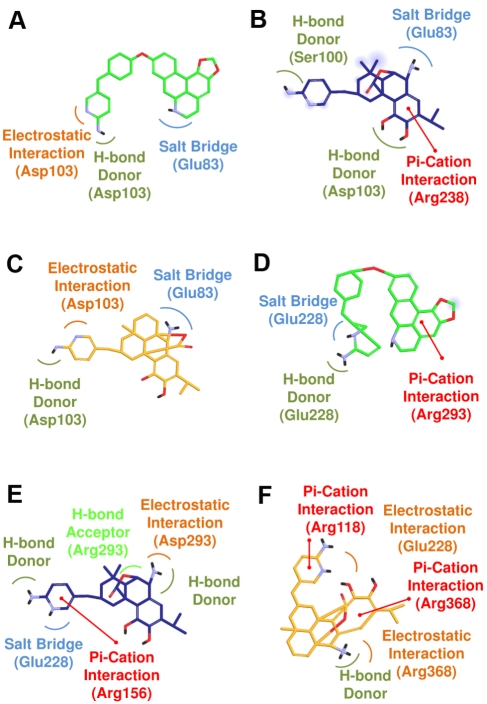
Key features of TCM candidates for stable binding in H1 and N1.(A) Xylopine_2 in H1, (B) Rosmaricine_14 in H1, (C) Rosmaricine_15 in H1, (D) Xylopine_2 in N1, (E) Rosmaricine_14 in N1, and (F) Rosmaricine_15 in N1.